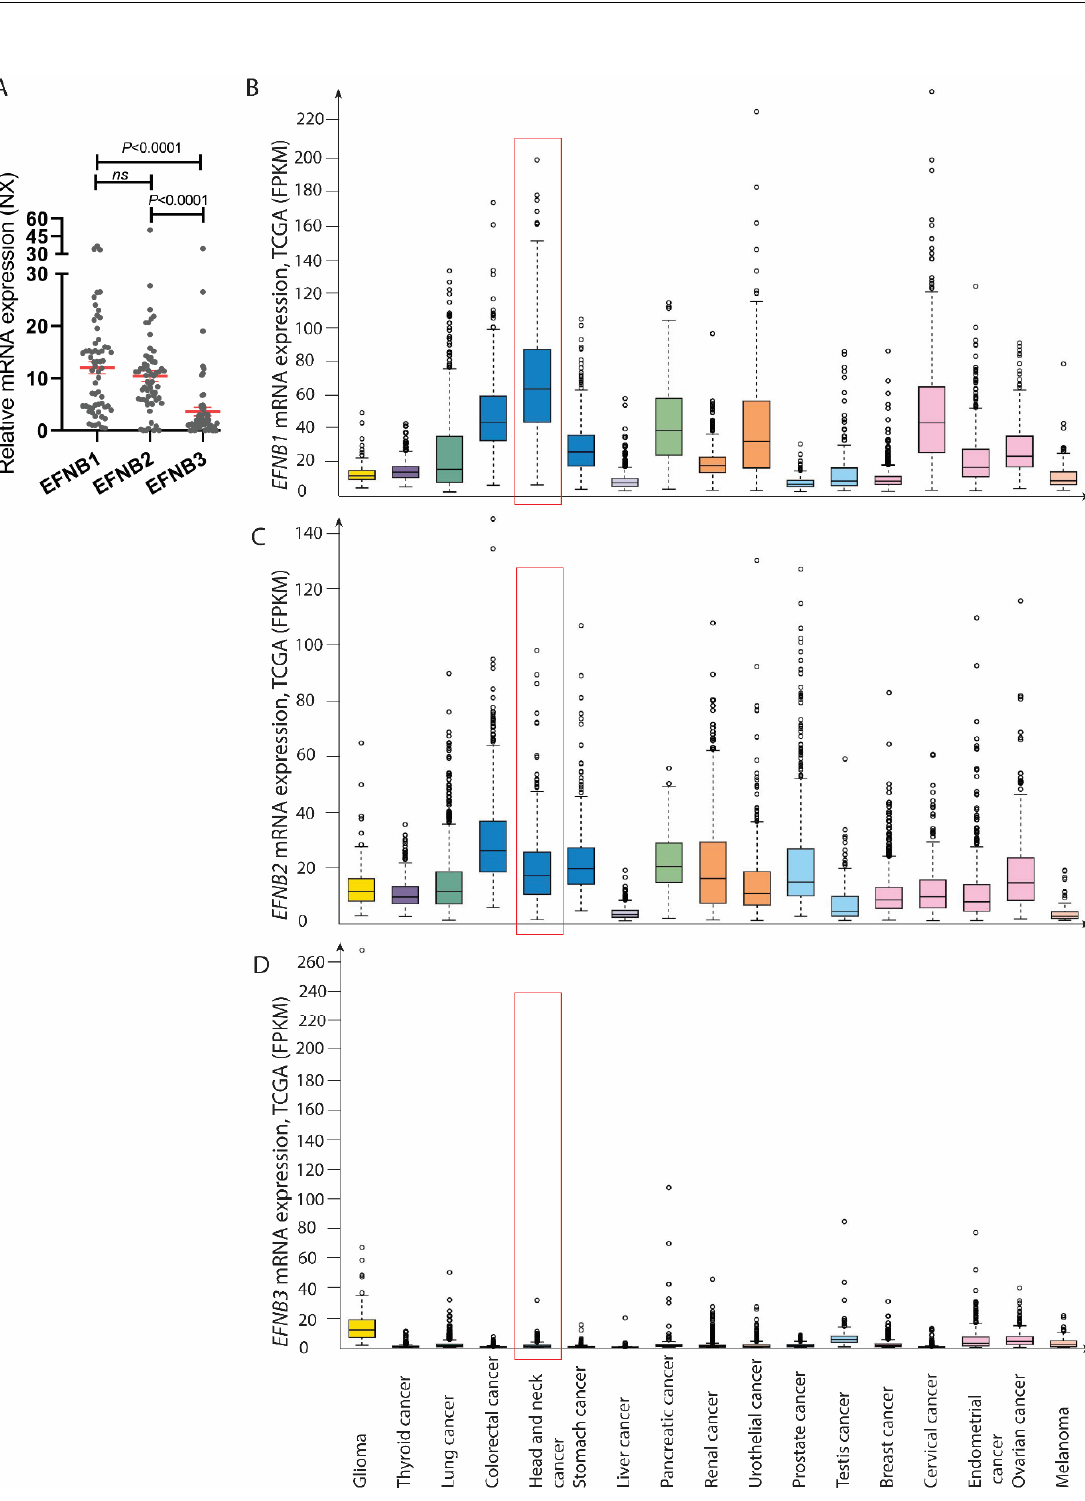
Figure 3. mRNA expression levels of EFNB1 and EFNB2 were significantly higher than that of EFNB3 in normal and malignant lesions. ( A ) Consensus mRNA data for EFNB1 , EFNB2 and EFNB3 for different organs including the tongue were exported from the Human Protein Atlas and the expression of the respective genes was compared. ( B – D ) mRNA expression data for 17 different cancer types including HNSCC (consisting of 62% of OSCC) [33] from the TCGA datasets were exported from the Human Protein Atlas portal. mRNA expression levels of EFNB1 and EFNB2 were higher in various human malignancies as compared to that of EFNB3 . Red boxes mark expression in HNSCC. FPKM: number Fragments Per Kilobase of exon per Million reads.